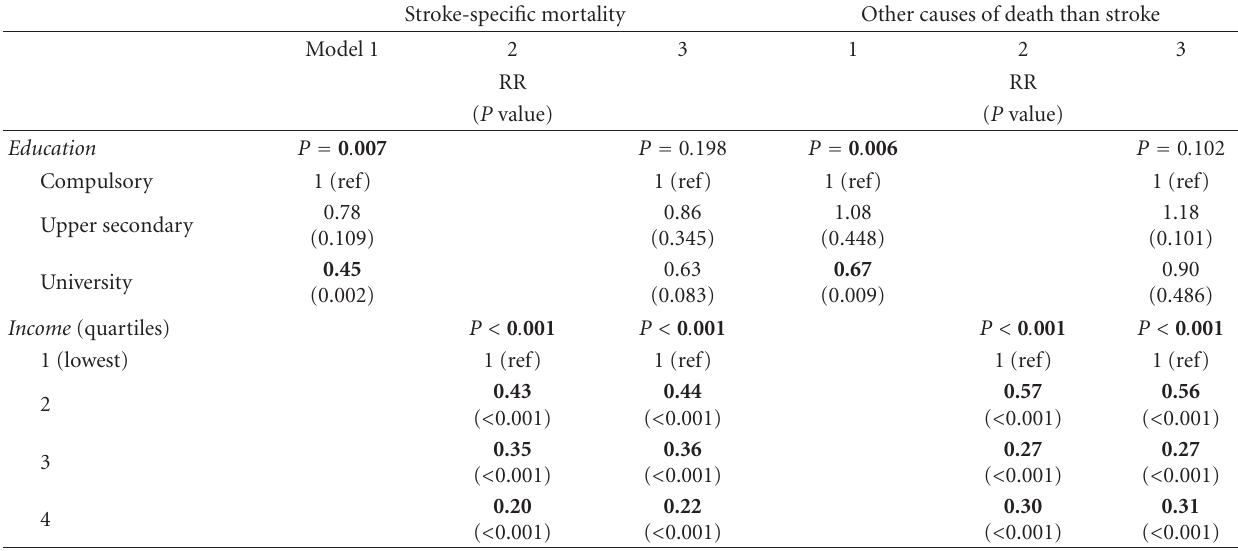
Table 3: Relative risk of dying after a cerebral infarction ( n =